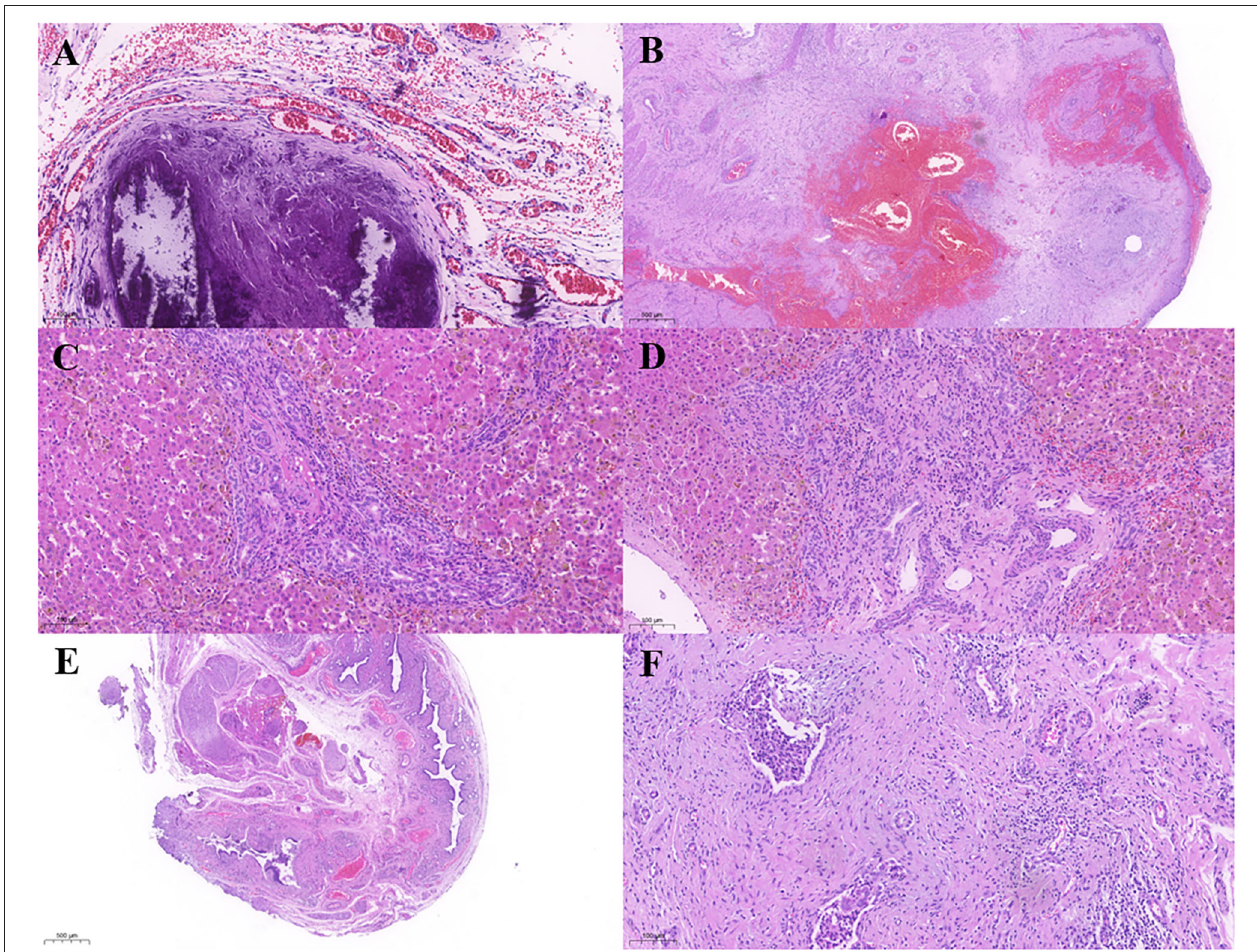
FIGURE 2 | (A) Intestinal wall calcification. (B) Intestinal atresia with multinucleated giant cells. (C,D) Hepatic cell swelling, cholestasis, fibrosis in the portal area, inflammatory cell infiltration, small bile duct hyperplasia, vascular hyperplasia, and bile duct plate malformation. (E) Gallbladder atrophy, fibrous hyperplasia, surrounding bulky nerve fibers. (F) Fibrous tissue shows branching bile ducts and nerve fibers infiltrated with inflammatory